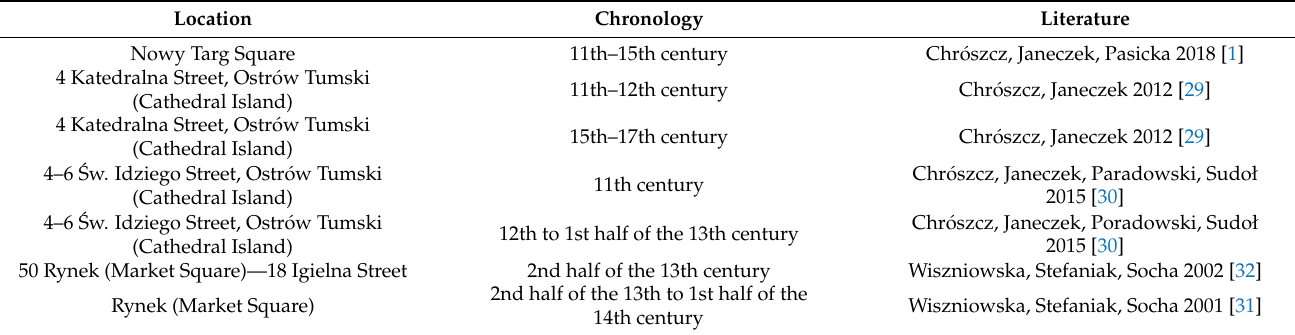
Table 1. Chronology and location of individual archaeozoological materials from archaeological research in Wrocław.